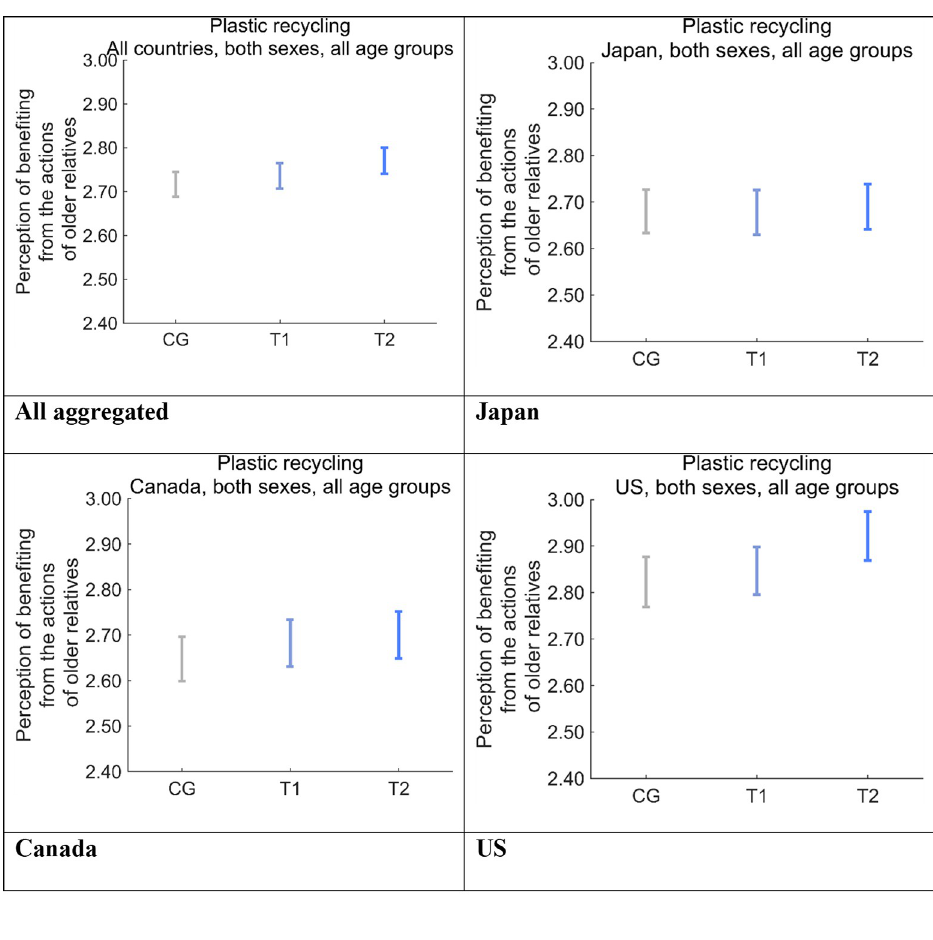
Fig 12. Perception that the respondent has benefited from the actions of relatives belonging to older generations after receiving one of the nudge message interventions. Error bars show 95% confidence intervals. CG, control group; T1, treatment group 1; T2, treatment group